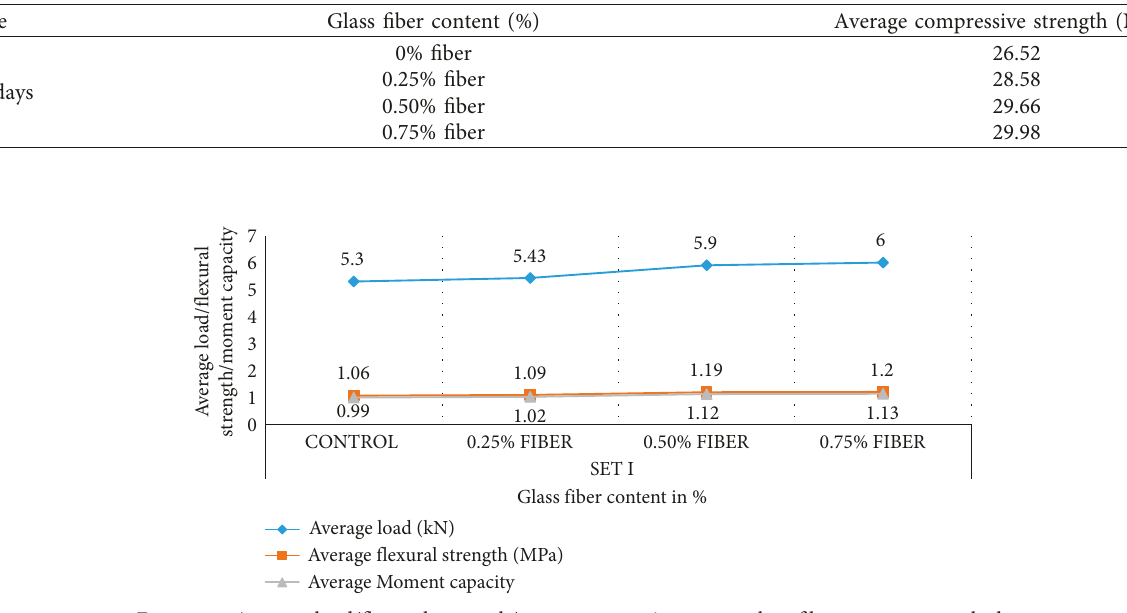
Table 2: Compressive strength of concrete cube.